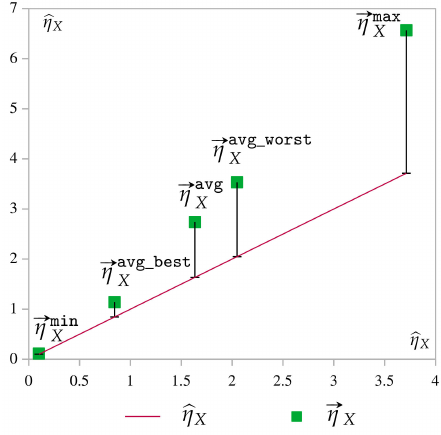
Figure 7. Estimates based on entry